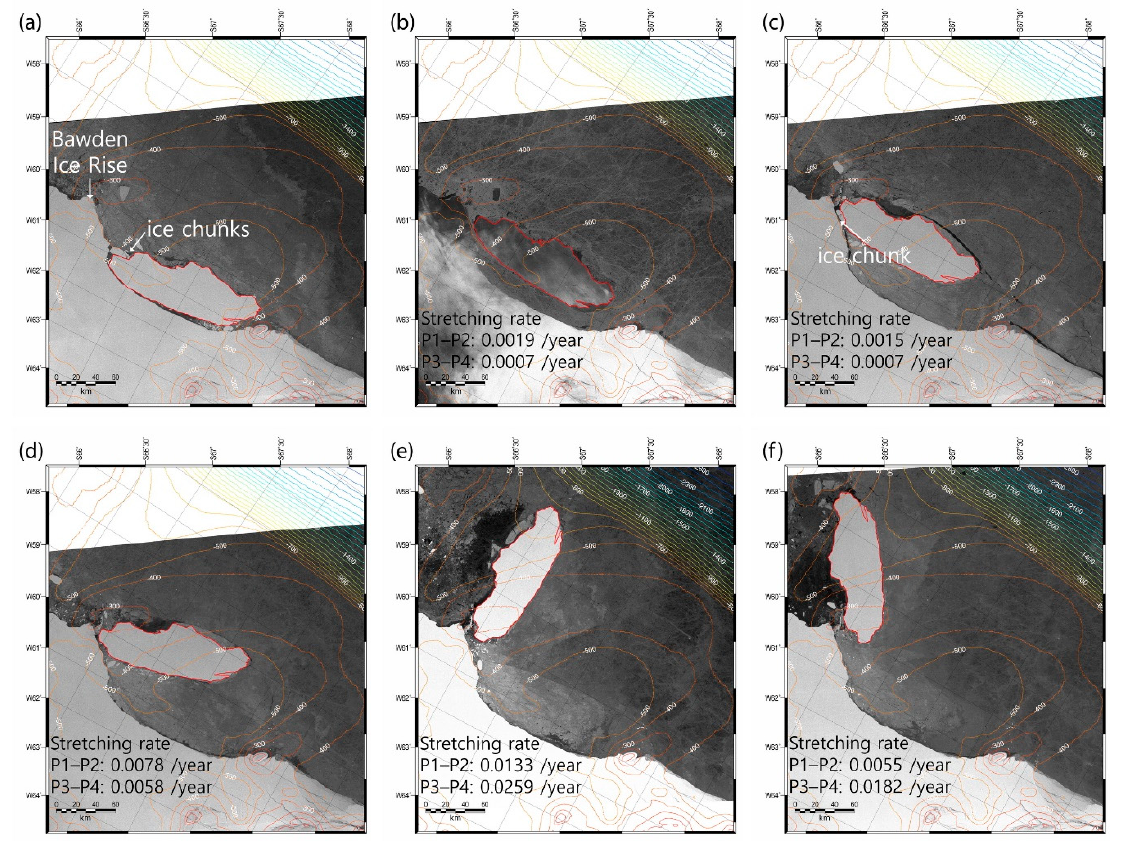
Figure 4. The Sentinel-1 SAR images of iceberg A68A acquired on ( a ) 15 August 2017; ( b ) 12 January 2018; ( c ) 18 May 2018; ( d ) 17 July 2018; ( e ) 16 September 2018; and ( f ) 27 November 2018.